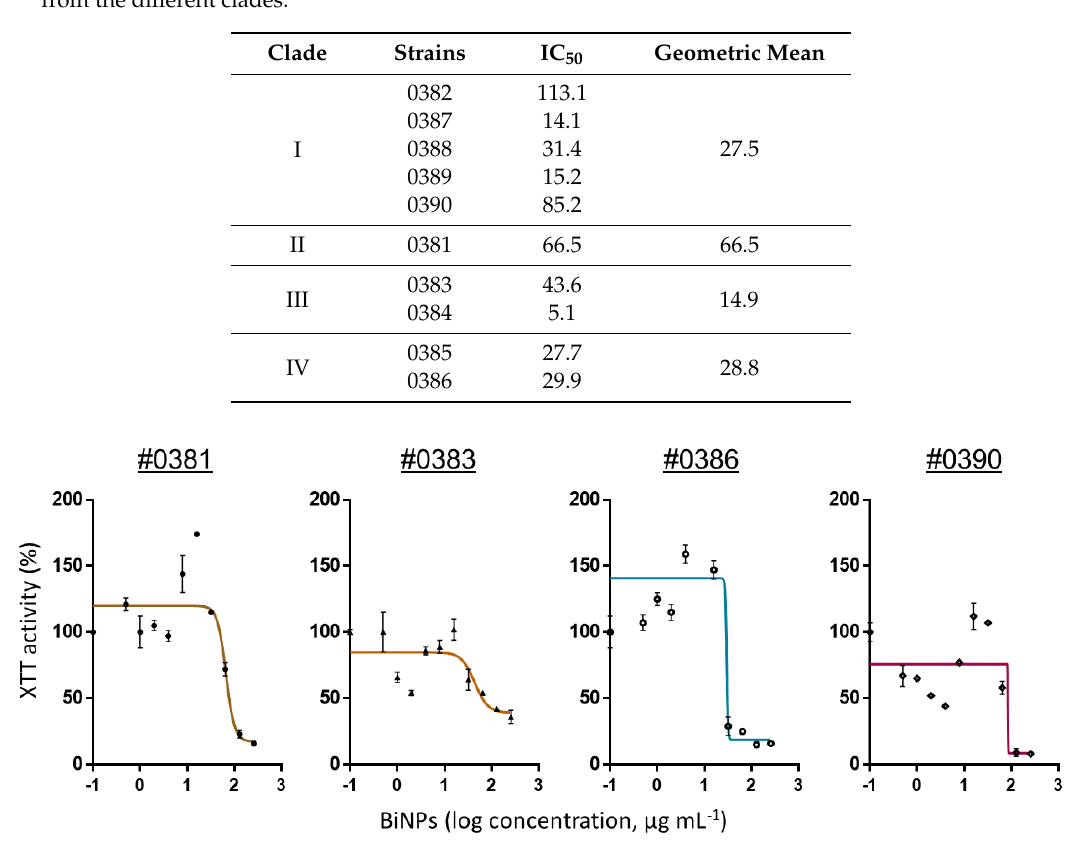
Figure 1. BiNPs reduce the ability of C. auris to form biofilms during the biofilm formation stage. The dose–response curves (continuous line) show the effect of the BiNPs (as XTT absorbance readings) during biofilm formation in representative strains from the four clades. The individual points show the average absorbance % over the BiNP concentration, whereas de vertical bars in each point represent the standard deviation ( n = 6). Table 2. Calculated IC 50 (µg mL −1 ) for the biofilm inhibitory activity of BiNPs against C. auris strains from the different clades.